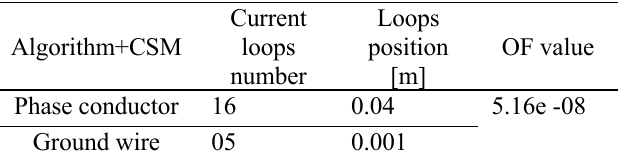
Table 2: Optimum values of CSM.